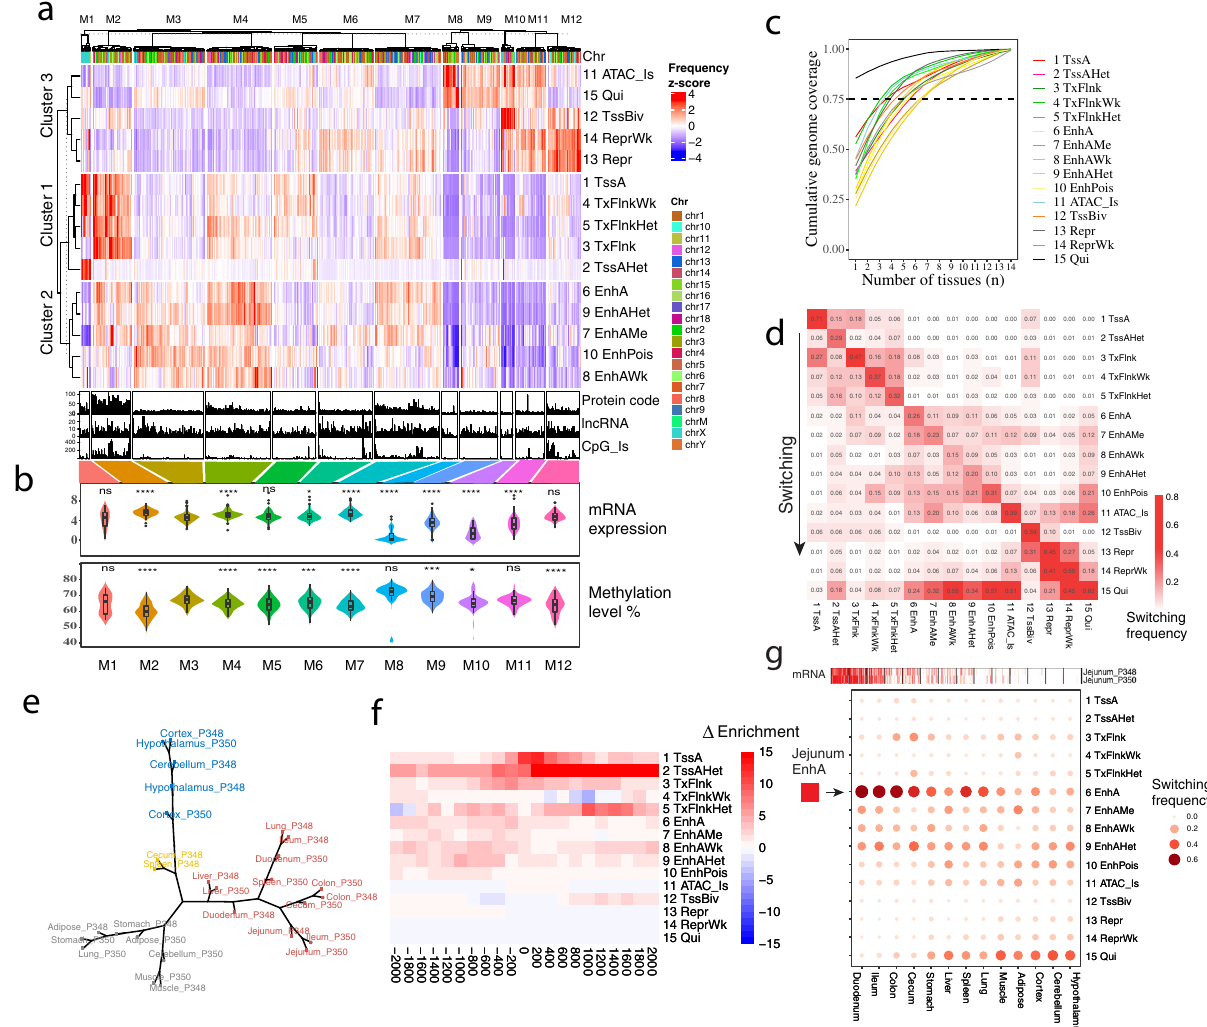
Fig. 3 Genome-wide chromatin state dynamics across tissues. a Clustering of 2 Mb intervals (1224 columns) into modules (M1 – M12) based on average chromatin state frequency across tissues in each interval. Number of protein-coding genes, lncRNA, and CpG islands in each interval shown in bottom. b Average mRNA expression (log 2 (TPM + 1)) of genes and average methylation level of 2 Mb intervals belonging to each module. M1 – M12 module was comprised of 24, 100, 183, 167, 111, 139, 168, 41, 98, 33, 75, 85 intervals, respectively. M3 was used as reference for the statistical two-sided t -test, where